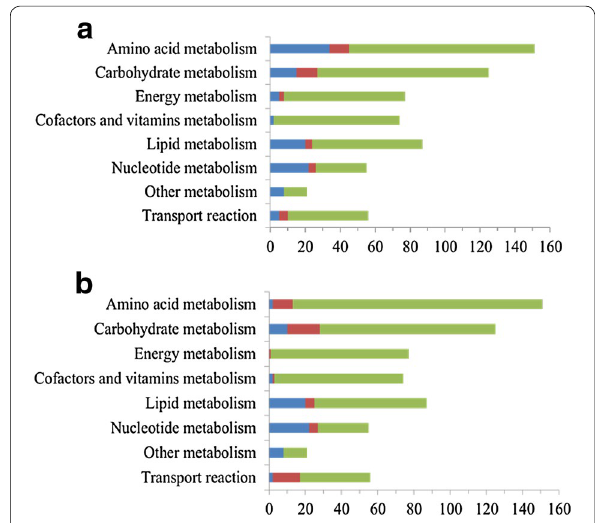
Fig. 2 The distributions of essential genes (in blue), partially essential genes (in red), and non-essential genes (in green) in cells grown in different media. a Minimal glucose medium; b yeast extract